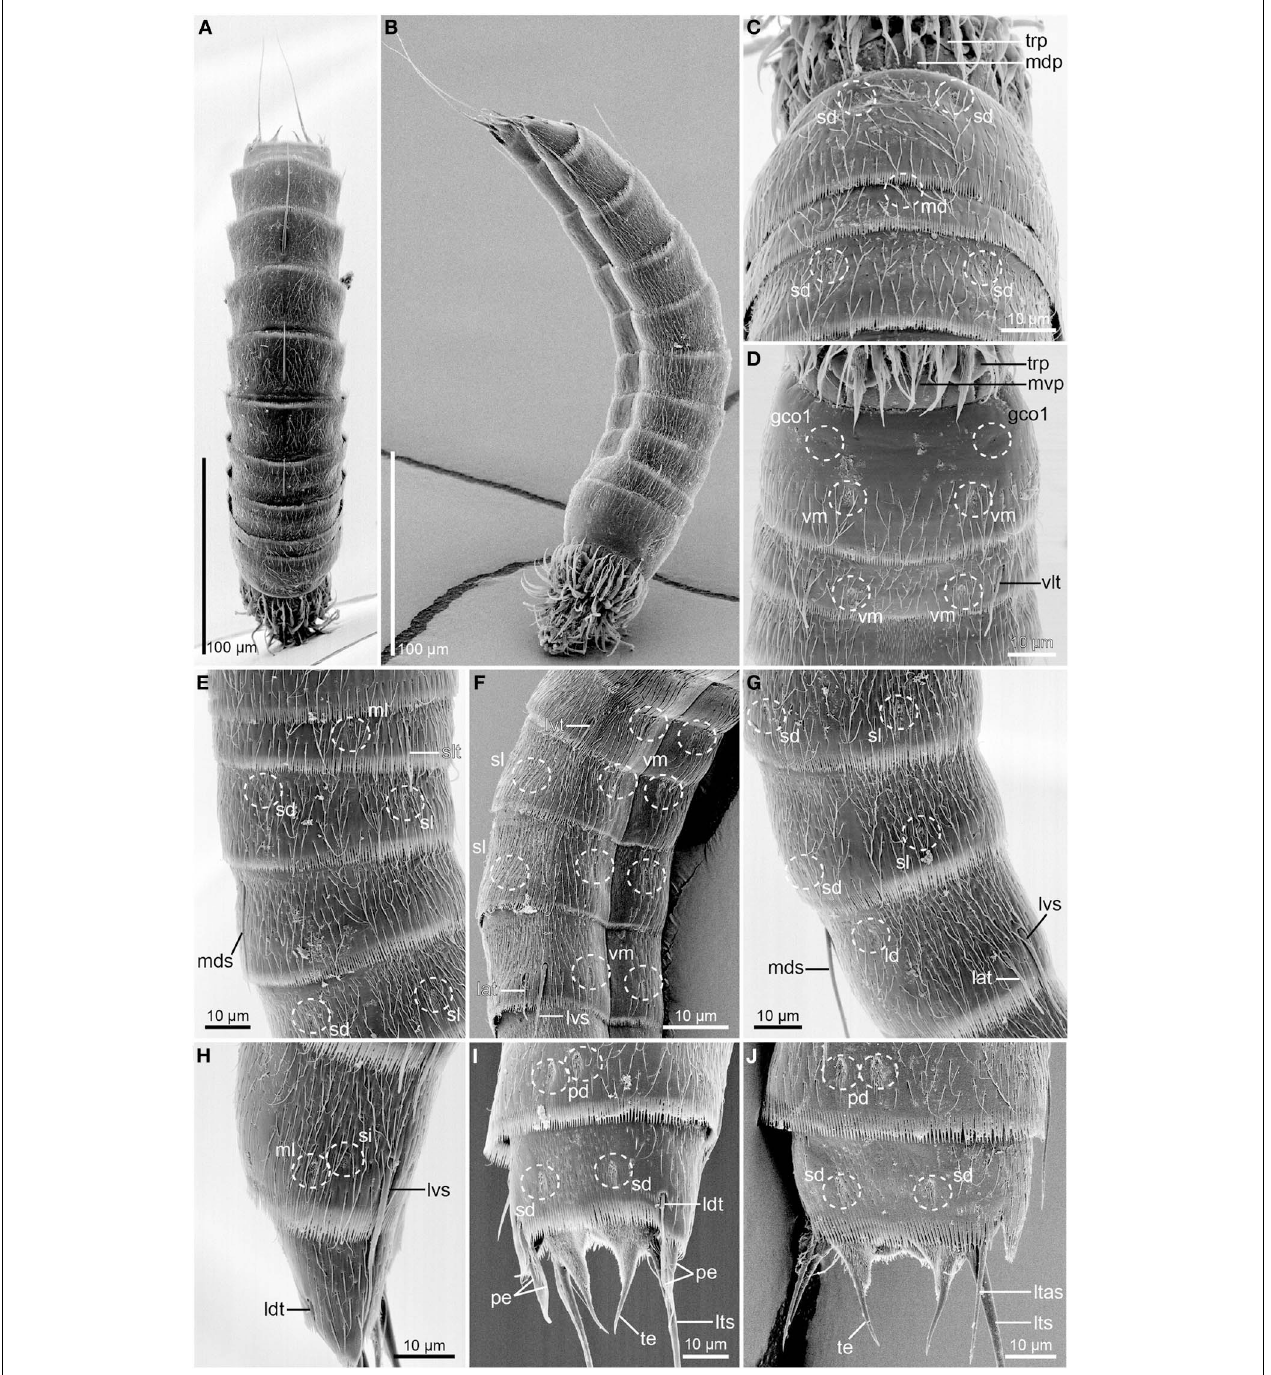
FIGURE 8 | Scanning electron micrographs of Echinoderes skipperae sp. nov. (A–E) and (G–I) male paratype (KIN-742); (F,J). female paratype (KIN-740). (A) Dorsal overview. (B) Lateral overview. (C) Segments 1 to 3, dorsal view. (D) Segments 1 to 3, ventral view. (E) Segments 2 to 4, lateral view. (F) Segments 5 to 8, lateroventral view. (G) Segments 6 to 8, lateral view. (H) Segments 9 to 10, lateral view. (I) Segments 9 to 11, dorsal view of male. (J) Segments 9 to 11, dorsal view of female. Abbreviations: gco1, glandular cell outlet